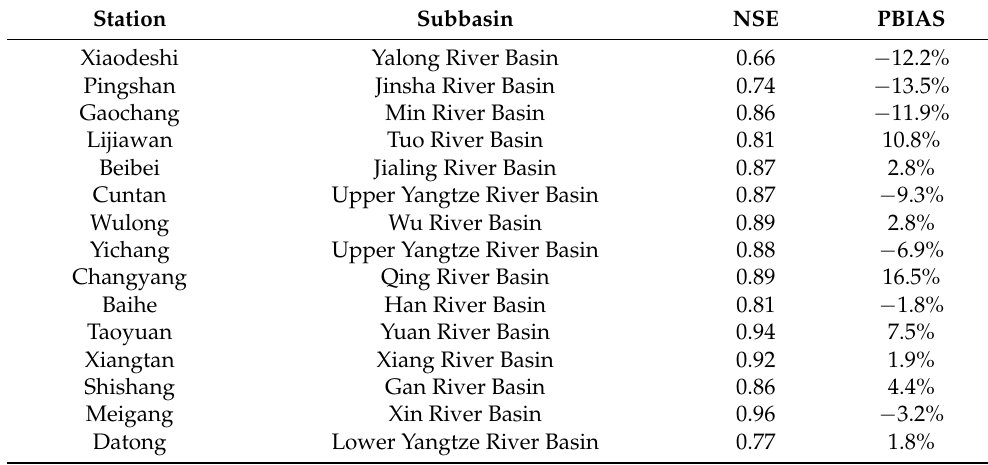
Table 4. Simulation performance of discharge process at 15 hydrological stations in the Yangtze River